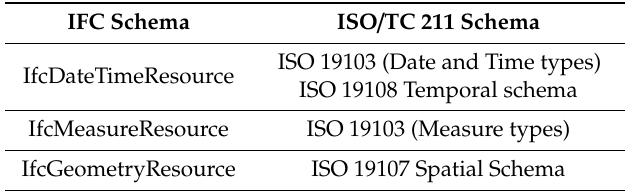
Table 9. The studied IFC resource schemas and counterpart ISO / TC 211 abstract conceptual schemas.